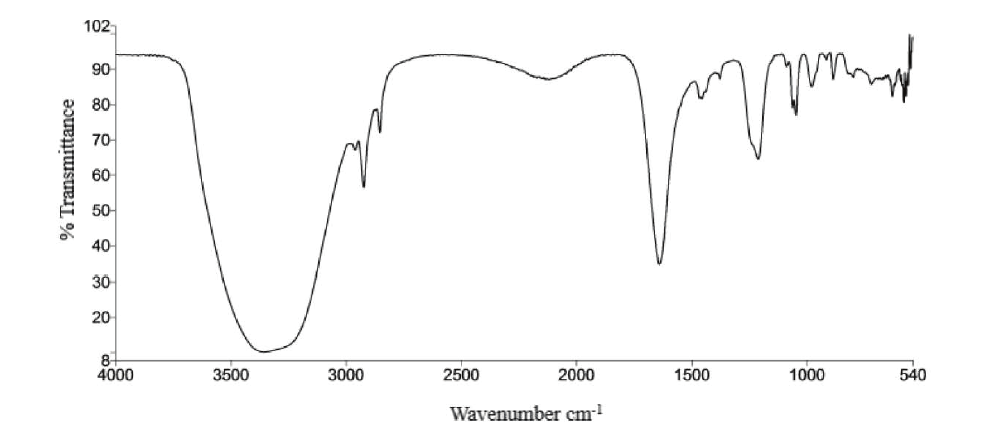
Fig. 2 – Infrared spectra of microemulsion absorption bands in the range of 400–4000 cm